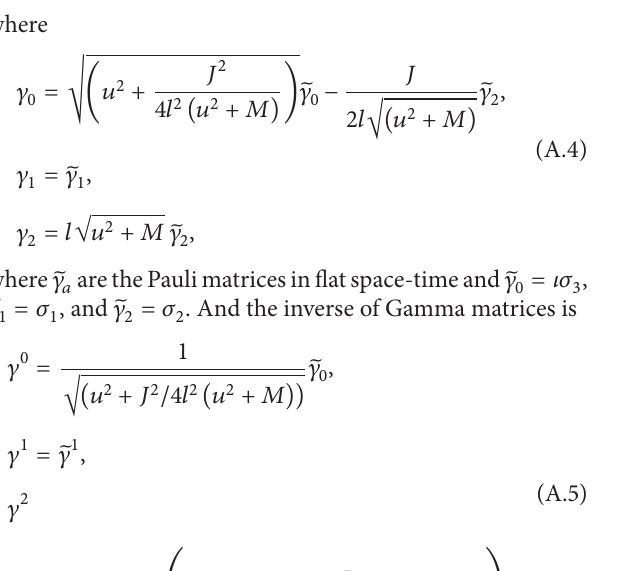
Figure 4: The coefficients of 𝑐 to the 1 /𝜇 in